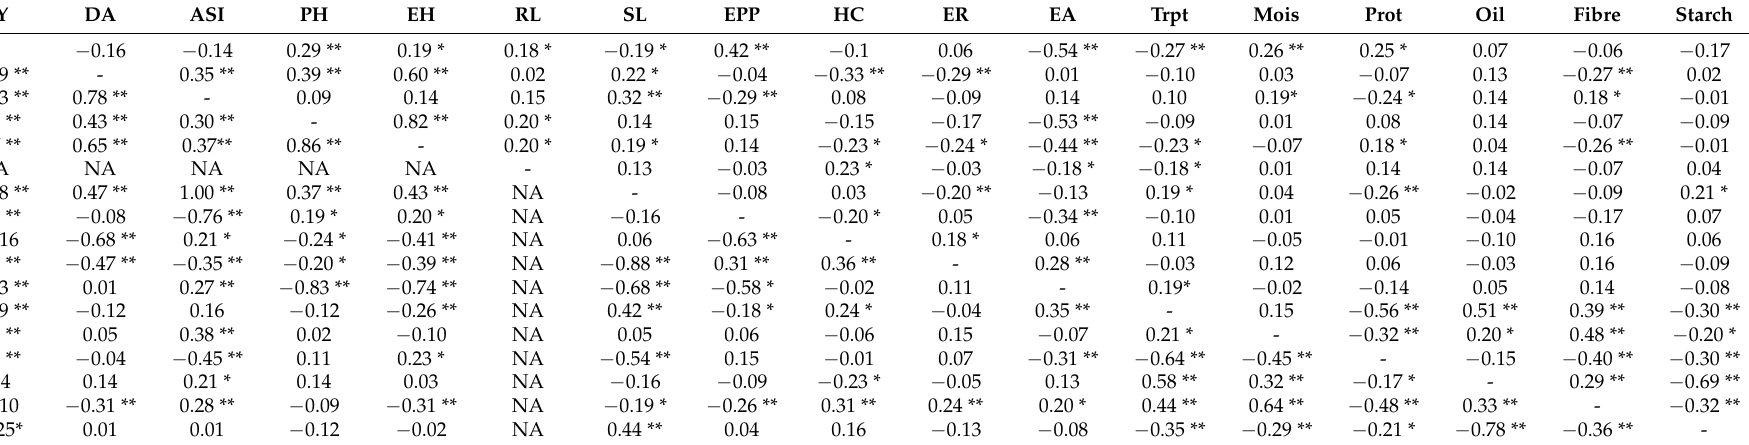
Table 5. Phenotypic correlation (r P ) (above diagonal) and genotypic correlation (r G ) coefficients (below diagonal) between grain yield, and agronomic and quality traits of maize